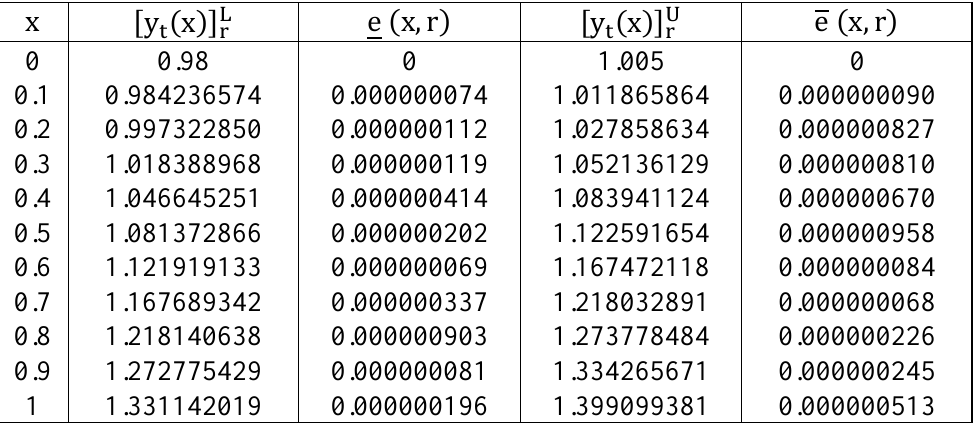
Table (2): Trial solutions for example (1), r =